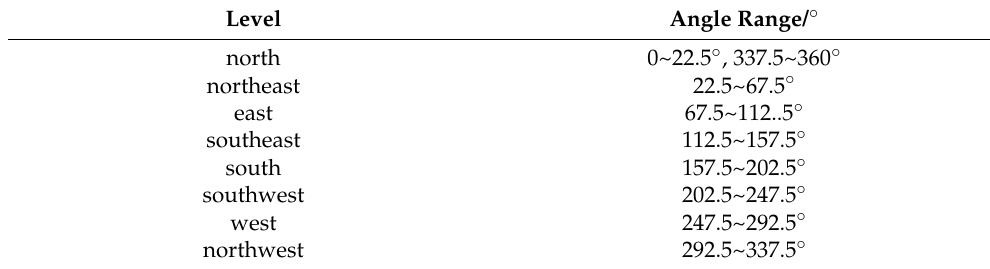
Table 4. Aspect classification.